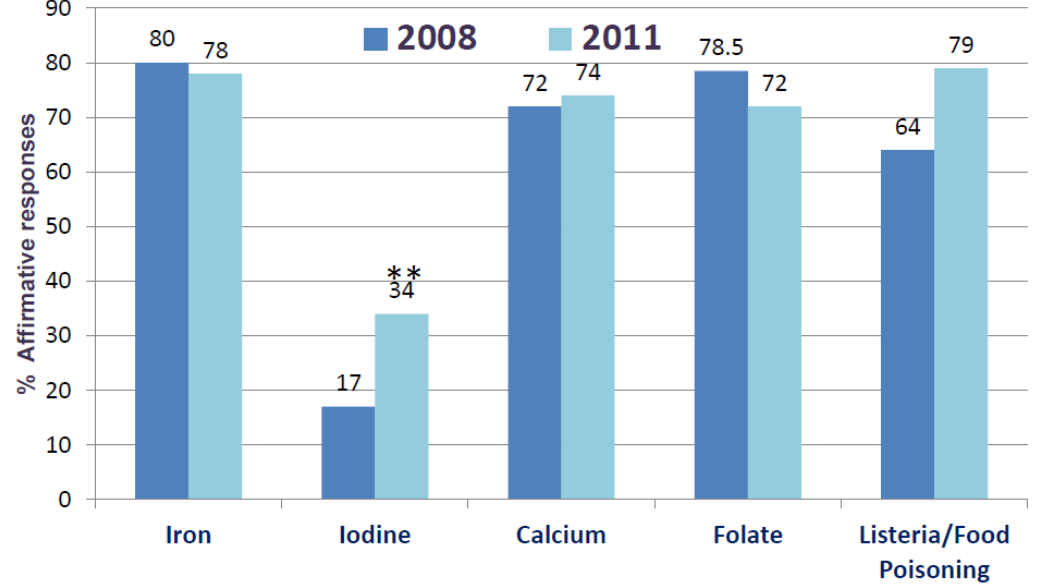
Table 3. Numbers of pregnant women ( n ) reporting particular sources of advice for different nutrition related topics (pregnant women 2011; n = 145) (adapted from [13]). Source of Advice Iron Iodine Calcium